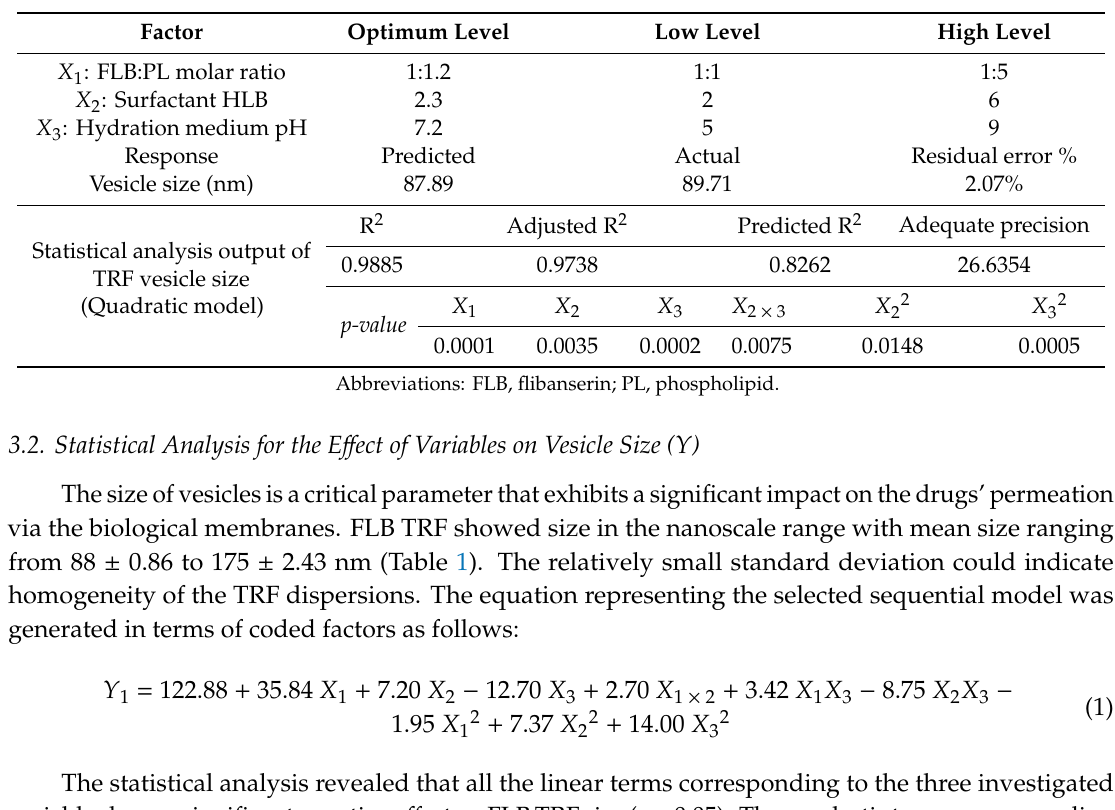
Table 2. Statistical analysis of the measured FLB TRF vesicle size, the composition of the optimized formulation, and its predicted and observed